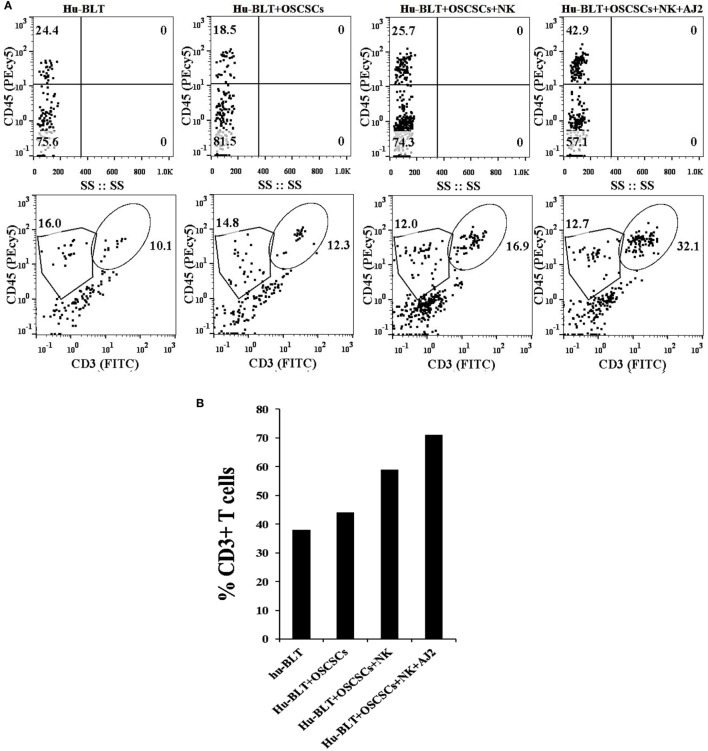
Increased percentages of CD45+and CD3+ T cells in gingiva of tumor-bearing mice injected with the NK cells and fed with AJ2. Gingiva from oral tumor-bearing mice injected with NK cells and fed with and without AJ2 were harvested and single-cell suspensions were prepared as described in the Section “Material and Methods.” Percentages of CD45+ and CD3+ T cells in gingiva in four groups of mice were determined using flow cytometric analysis after staining with the respective PEcy5-conjugated and FITC-conjugated antibodies. Isotype control antibodies were used as controls (A,B).